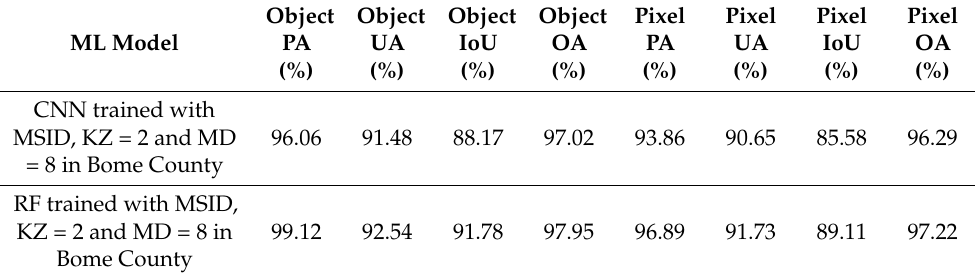
Figure 10. ( a ) Location of the new testing zone; ( b ) true-color RGB image of the new testing zone and ( c ) pixel-level snow cover of the new testing zone based on visual interpretation. Table 5. Performance evaluation of snow mapping in the testing zone (Qimantag Mountain